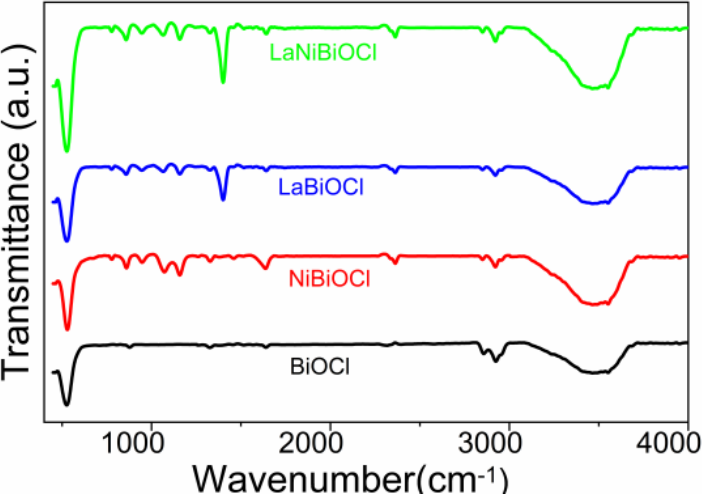
Figure 2. FT–IR spectra of as-prepared samples. Figure 2. FT−IR spectra of as-prepared samples. The chemical state of surface elements and the effect of doping on the coordination environment were further analyzed by the XPS method (Figure 3). Bi, Cl, and O were observed in all samples (Figure 3a). However, Ni and La were not observed in a survey and high-resolution scan of NiBiOCl, LaBiOCl, and LaNiBiOCl, which might be due to the low doping amount of Ni (2‰) and La (2‰). The high-resolution Bi 4f spectra are shown in Figure 3b. For BiOCl, two characteristic peaks at 159.55 eV and 164.85 eV could be ascribed to Bi 4f 7/2 and Bi 4f 5/2 , indicating the existence of Bi 3+ [45,46]. The spacing of the two peaks was 5.3 eV, indicating the normal state of Bi in BiOCl [47]. After doping of Ni and/or La, these two peaks shifted to a lower position because of the increase in the electron density of Bi, which was the result of an increase in oxygen defects formed from the substitution of Bi by Ni or/and La. The high-resolution Cl 2p (Figure 3c) of BiOCl showed two peaks at 199.85 eV and 198.2 eV, which were ascribed to Cl 2p 1/2 and Cl 2p 3/2 , respectively. For high-resolution O 1s spectra (Figure 3d), multiple chemical states were observed in NiBiOCl, LaBiOCl, and LaNiBiOCl. The peaks at about 530 and 532 eV were ascribed to lattice oxygen and oxygen defects [48]. The binding energy of the oxygen defect of LaNiBiOCl shifted 0.38 eV to the lower direction, while the corresponding shifts for NiBiOCl and LaBiOCl were 0.2 and 0.1 eV, respectively. This result suggested that there were more defects or water adsorbed on the surface of LaNiBiOCl, which was beneficial to improving its